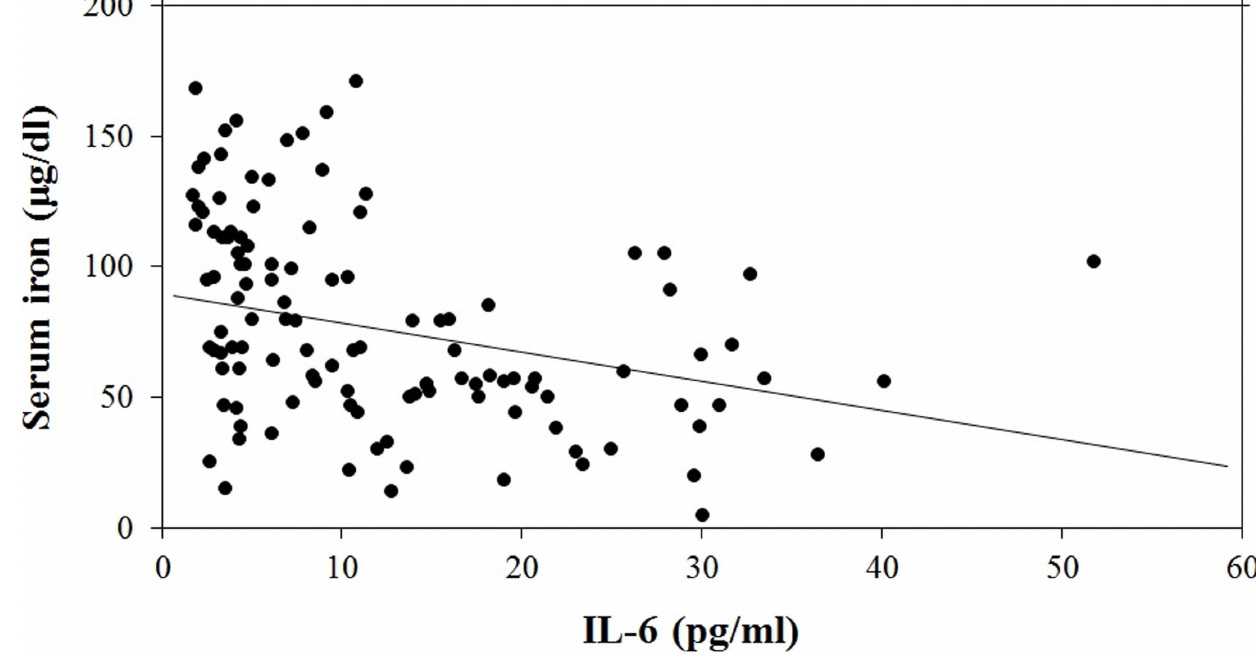
Figure 2. The relationship between serum iron concentration and IL-6 levels in all enrolled subjects. The result indicated that the serum iron concentration was negatively correlated with circulating IL-6 concentration in all study subjects. The linear relationship was well described by